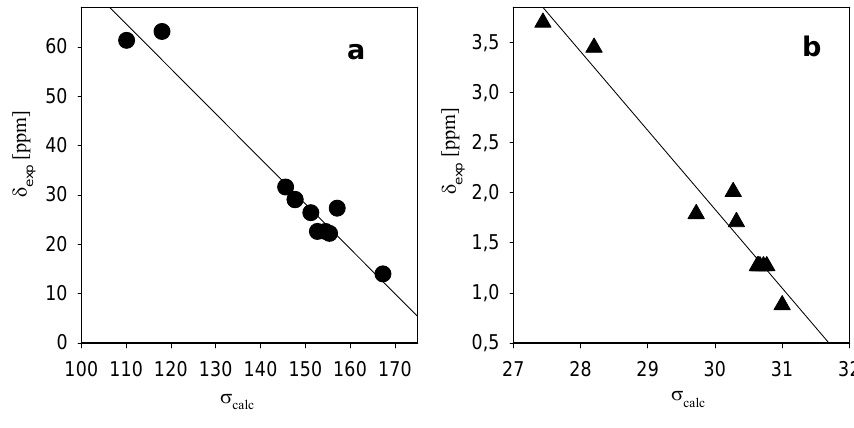
Figure 4. Plots of the experimental chemical shifts ( δ shielding ( σ ) from the GIAO/B3LYP/6-31G(d,p); N,N -dioctylazepanium bromide ( 1 ) calc